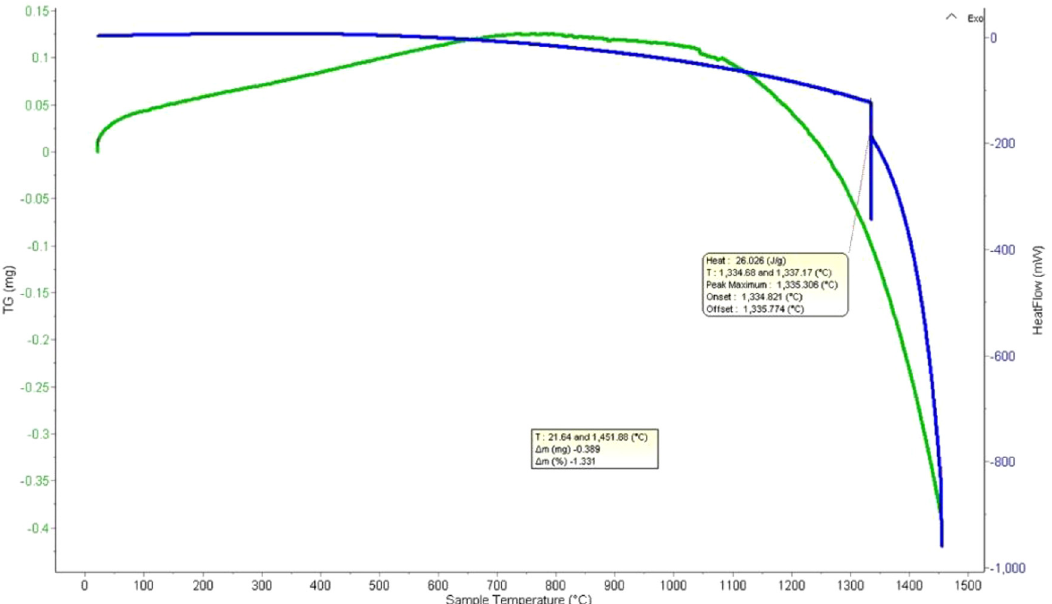
Fig. 11. The DSC-TG curve for yttria-doped zirconia coatings on graphite substrate.